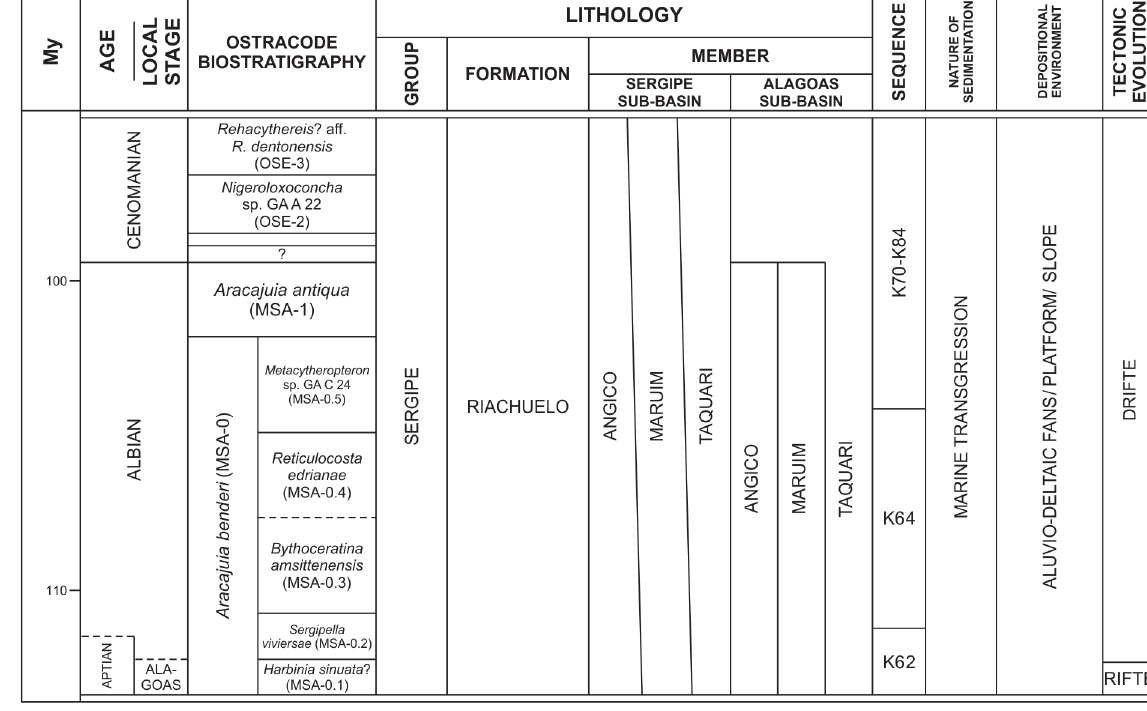
Fig. 2. Lithological and biostratigraphical profiles of the Riachuelo Formation, Sergipe-Alagoas basin, northeastern Brazil, after Campos Neto et al. (2007) and Antonietto et al.